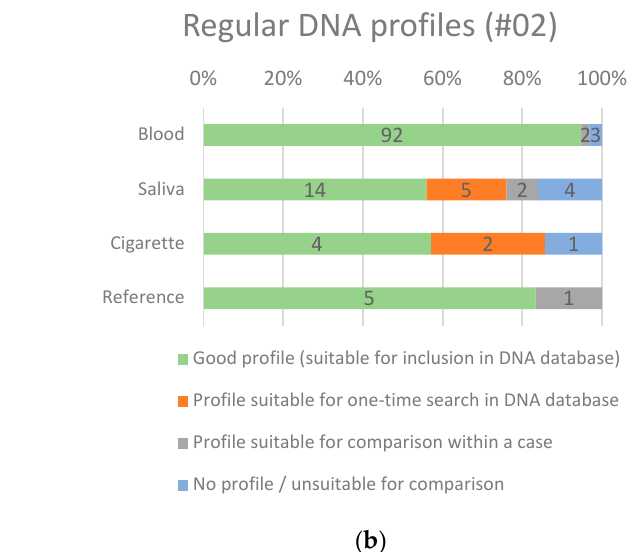
Figure 3. ( a ) DNA profiles generated by decentral rapid procedure. ( b ) DNA profiles generated by regular procedure.